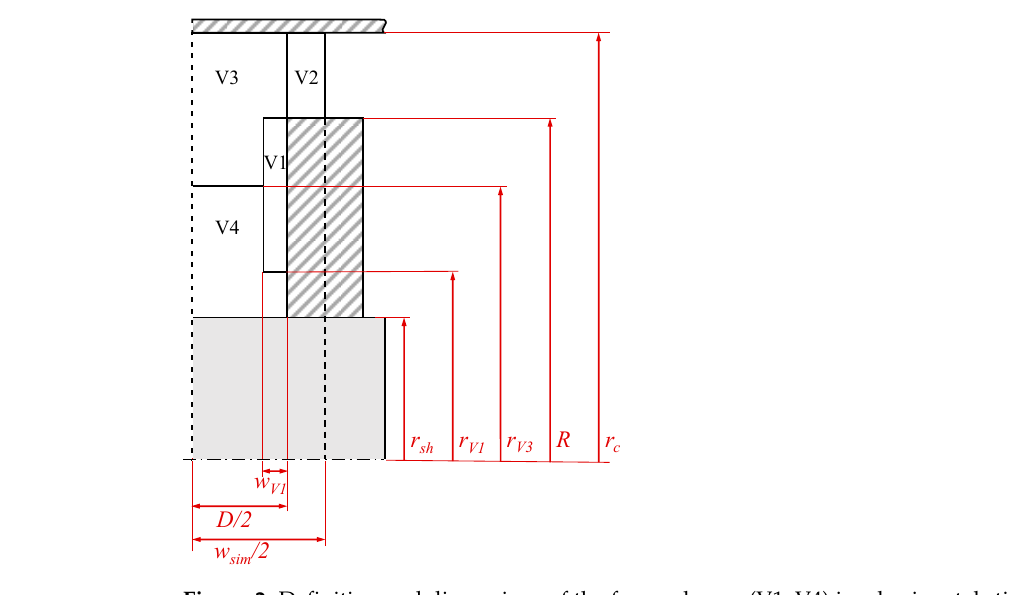
Figure 2. Definition and dimensions of the four volumes (V1–V4) in a horizontal stirred media mill with a disc stirrer according to Stender et al. [7]. The cell element described by V1–V4 ranges from the middle of the disc to half of the length between the two discs. The scheme is not drawn to scale. Table 2. Dimensions of the investigated volumes as drawn in Figure 2.